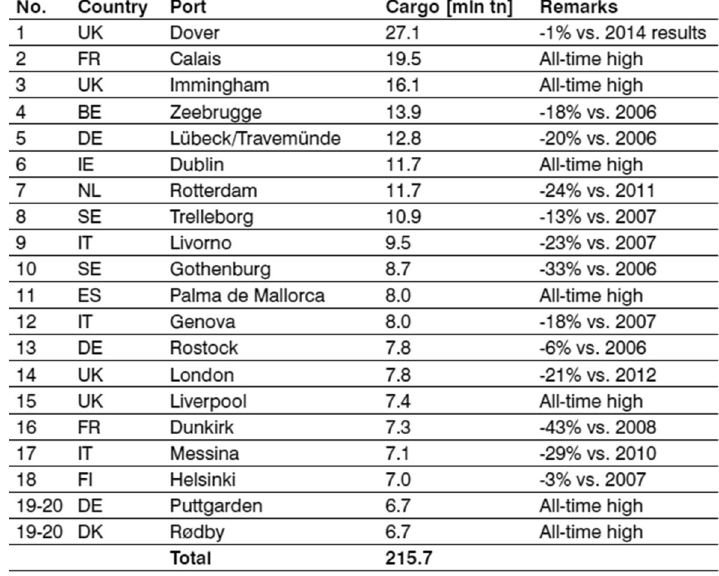
Fig. 1 Europe’s Top 20 ferry/ro-ro freight ports in 2015. Source (Habour Reviews 2017)